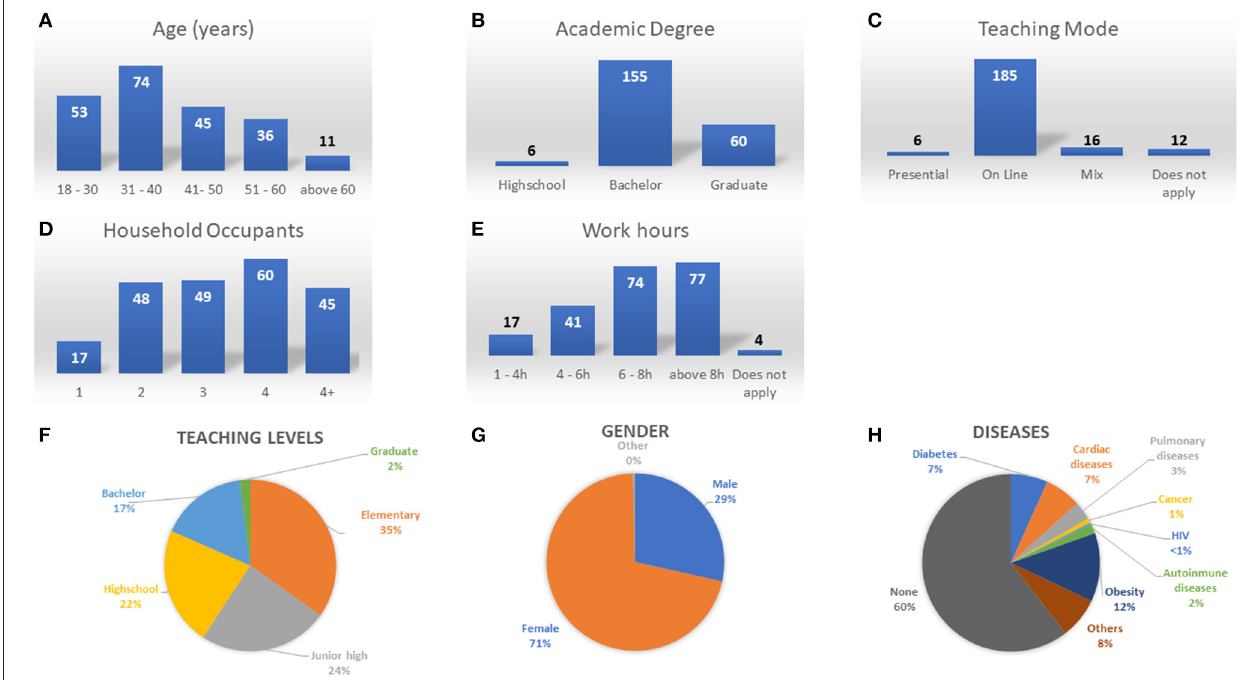
FIGURE 1 | Frequency count bar graphs for (A) Age, (B) Academic degree, (C) Teaching mode, (D) Household Occupants, (E) Work hours. Percentage distribution for (F) Teaching level, (G) Gender, (H)